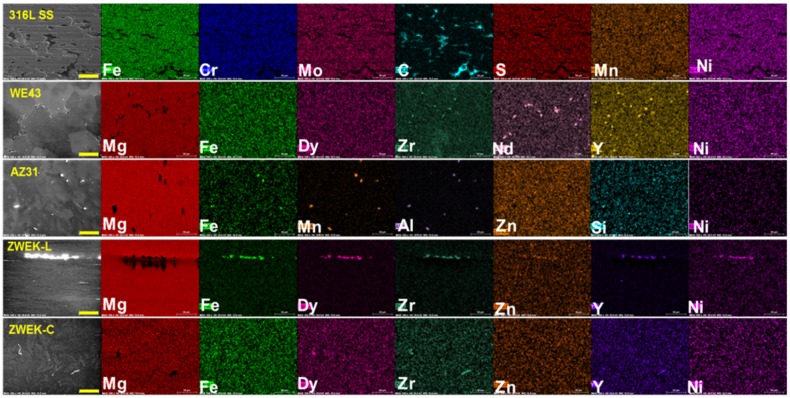
EDX mapping of aggregated elements.The aggregated elements were observed by EDX on the surface according to alloy’ fabrication procedure of 316L SS and Mg-based alloys. Scale bar = 50μm.